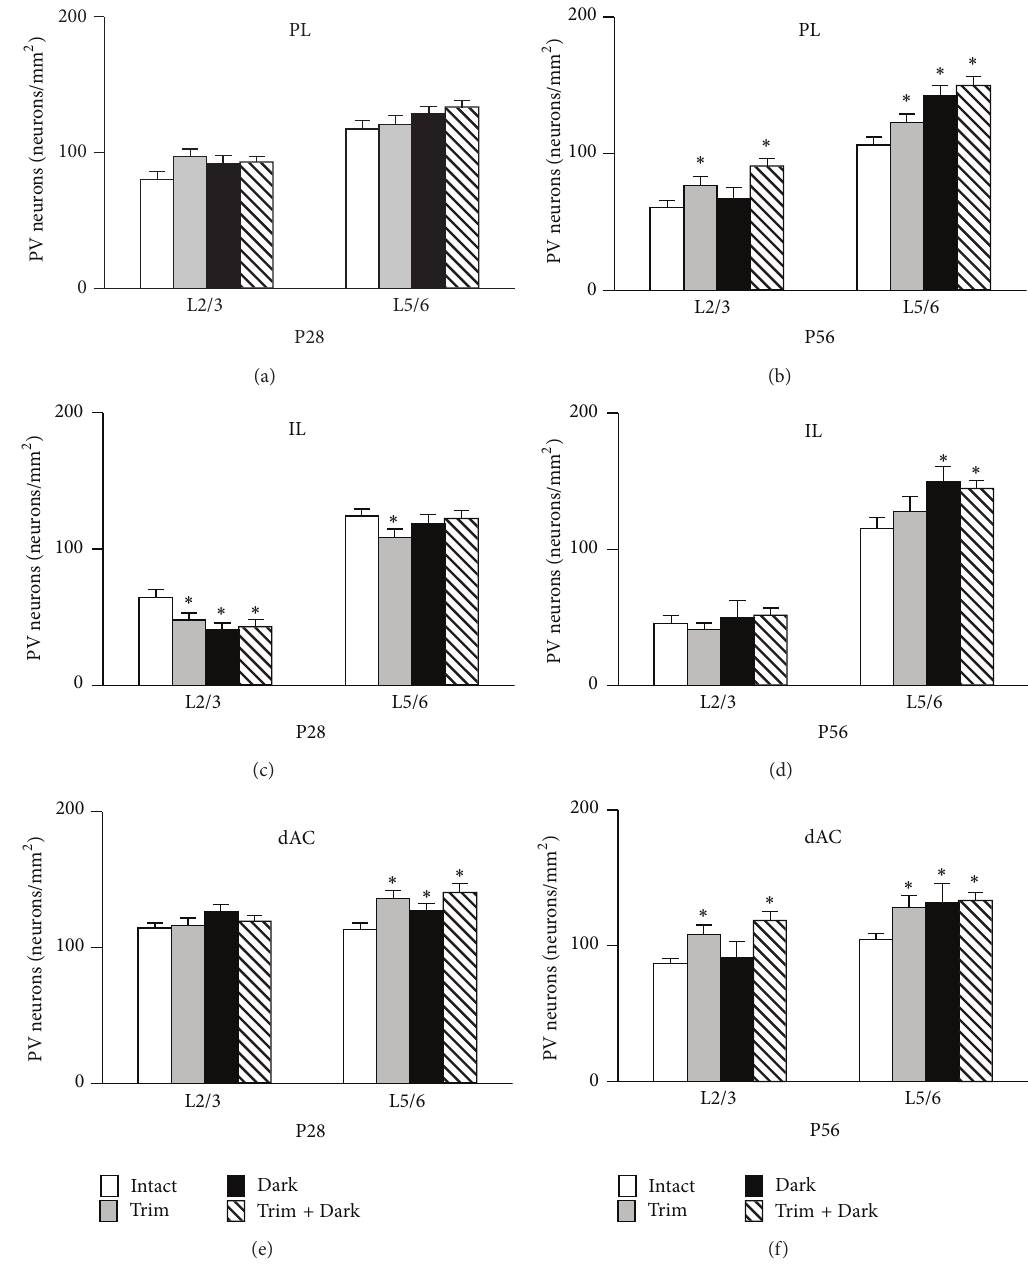
Figure 4: Sensory deprivation changes PV neuron density in the PFC. The density of PV neurons in the PL (a, b), IL (c, d), and dAC (e, f). PV neuron density at P28 (a, c, e) and P58 (b, d, f) in each area are shown. (a)-(b) The density of PV neurons was increased in L5/6 by sensory deprivation at P56. (c)-(d) The density of PV neurons in L2/3 was decreased at P28 by sensory deprivation, but it was increased in L5/6 at P56. (e)-(f) The density of PV neurons in L5/6 was increased with sensory deprivation at both P28 and P56. Data are expressed as mean density S.E.M. ( 𝑛 = 6 per group). Abbreviations are the same as in Figure 4. ∗ 𝑃 < 0.05 compared with intact mice.